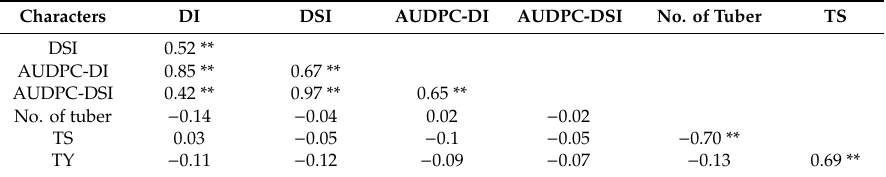
Table 8. Correlation coe ffi cients of DI, DSI, AUDPC-DI and AUDPC-DSI, number of tubers / plant (No. of tuber), TS (g / tuber), and TY (g / plant) of 96 Jerusalem artichoke varieties in late rainy